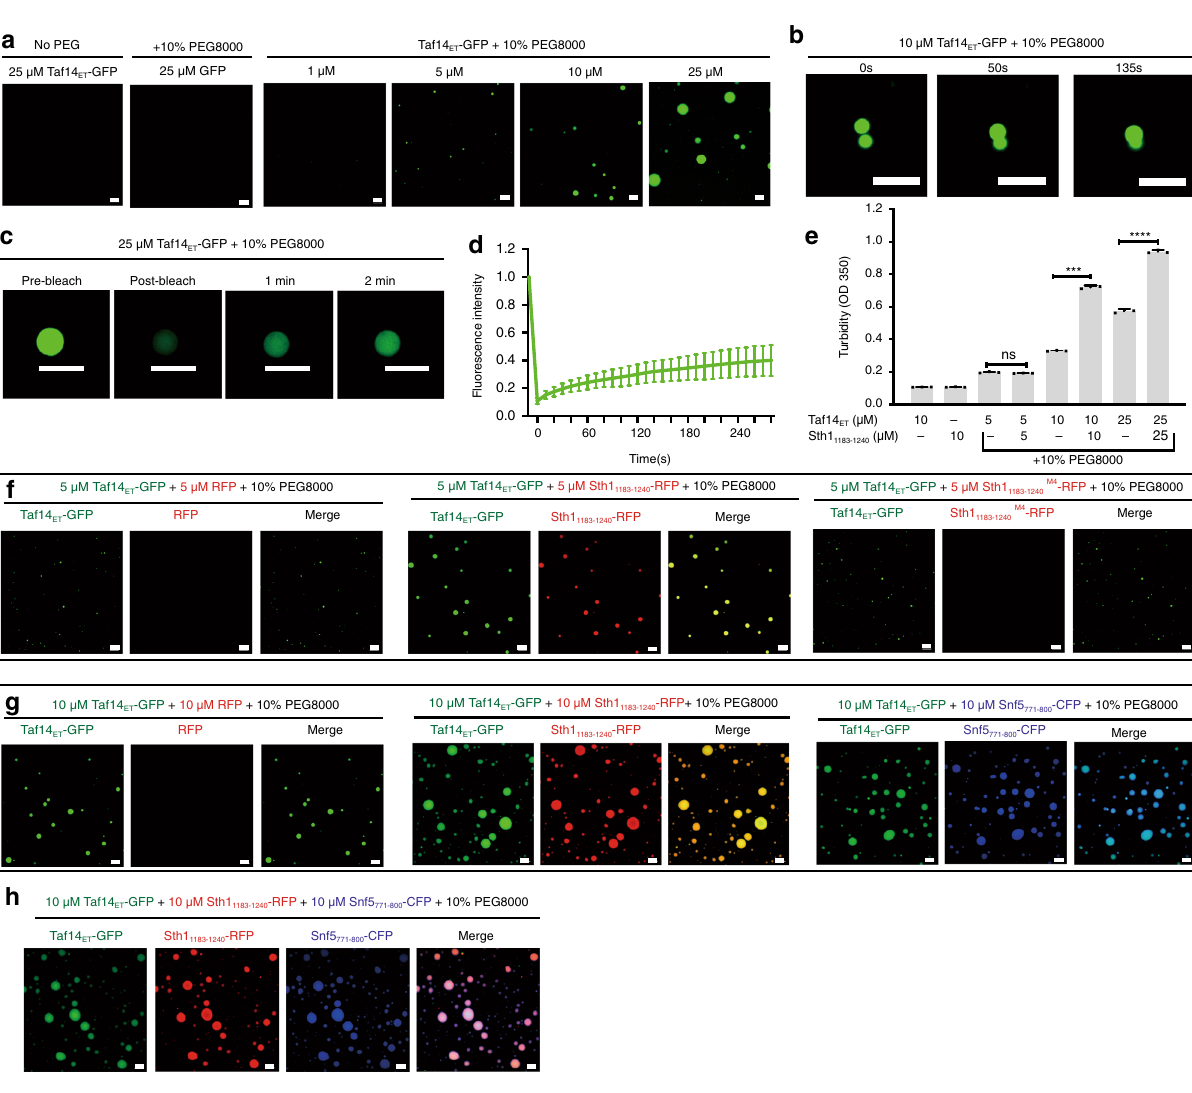
Fig. 5 Phase separation of Taf14 ET . a Representative fl uorescence microscopy images of the Taf14 ET – GFP fusion protein at different concentrations. The droplet formation buffer comprises 25 mM Tris-HCl, pH 8.0, 150 mM NaCl, 10% PEG8000. The scale bars indicate 10 µ m; note that the same scale applies to all of the panels. b Representative images of Taf14 ET -GFP at different time points showing the dynamic fusion of two droplets in the droplet formation buffer. c Representative images from FRAP experiments con fi rm the fl uidity of Taf14 ET -droplets. d Quanti fi cation of the average intensity of recovered fl uorescence in the bleached region of droplets at 10 s intervals. All of the data are presented as means ± SDs ( n = 16). Source data are provided as a Source Data fi le. e Turbidity measurements as determined by light scattering at 350 nm. Sumo-Sth1 EBM signi fi cantly increases the turbidity of GST-Taf14 ET at 10 and 25 μ M protein concentrations. Error bars represent standard deviations of three replicates. NS for P > 0.05; *** for P < 0.001; **** for P < 0.0001; two-tailed Student ’ s t -test. Data are presented as mean ± SD, n = 3. f Representative images of the mixture of Taf14 ET -GFP (5 µ M) and Sth1 EBM -RFP (5 µ M) in the droplet formation buffer showing Sth1 EBM increased the phase separation of Taf14 ET . As controls, RFP or Sth1 EBM M4 -RFP did not affect the phase separation of Taf14 ET . g Representative images of the mixture of Taf14 ET -GFP and Sth1 EBM -RFP or Snf5 EBM -CFP in the droplet formation buffer. Both Sth1 EBM and Snf5 EBM strongly promoted the phase separation of Taf14 ET compared with the addition of RFP. h Representative images of a mixture containing the Taf14 ET -GFP, Sth1 EBM -RFP, and Snf5 EBM -CFP fusion proteins in droplet formation buffer. Note that all droplets contain all three fl uorescence signals, indicating colocalization of three